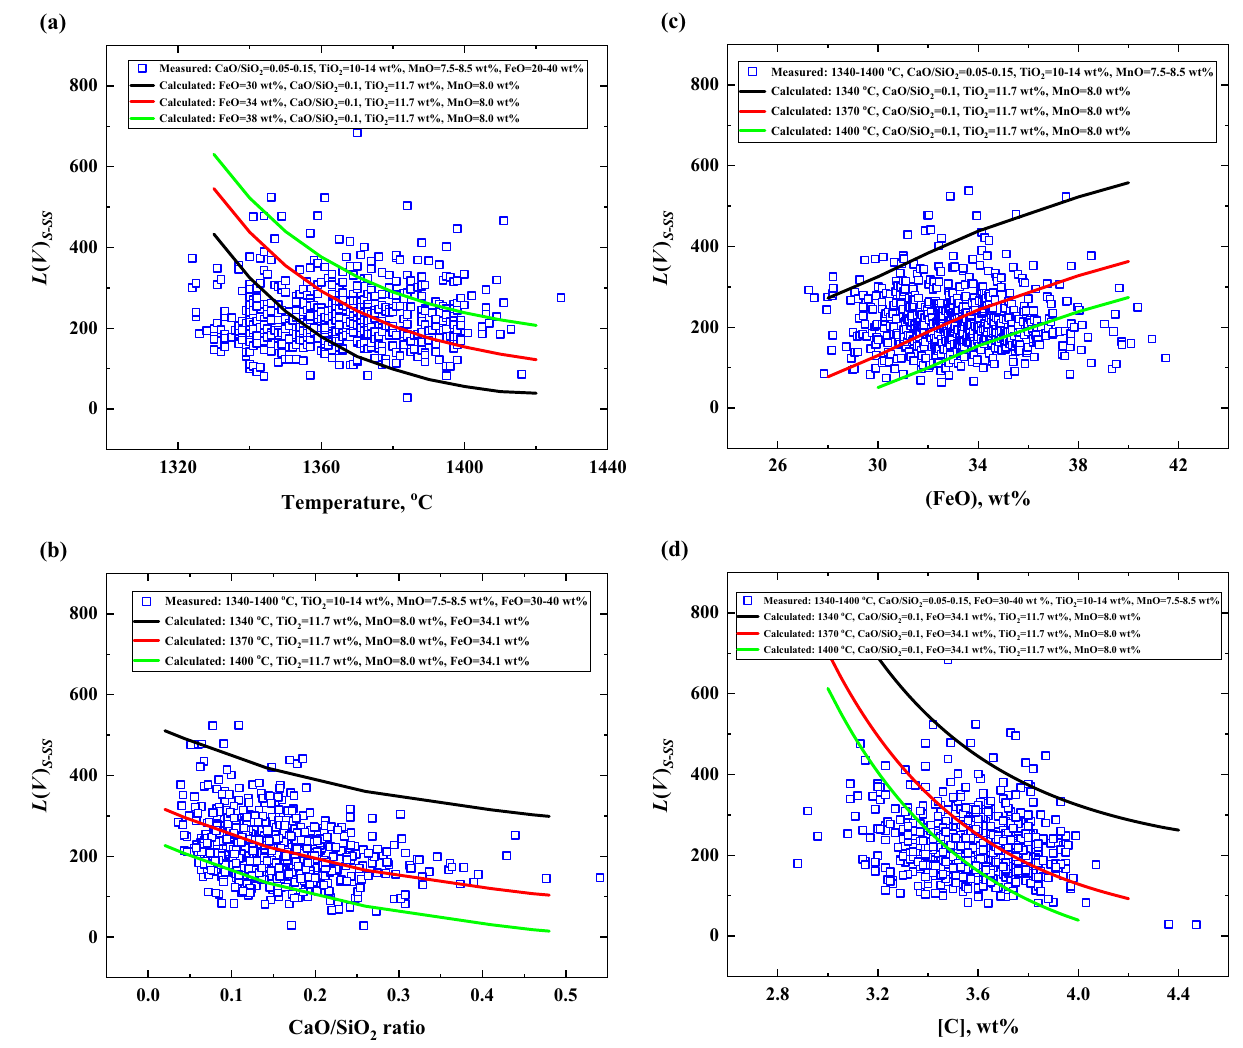
Figure 8: Variation of V distribution ratio between slag and semi - steel ( ) L V S−SS as a function of ( a ) temperature, ( b ) CaO/SiO 2 ratio, ( c ) FeO content in V - rich slag, and ( d ) C content in semi -